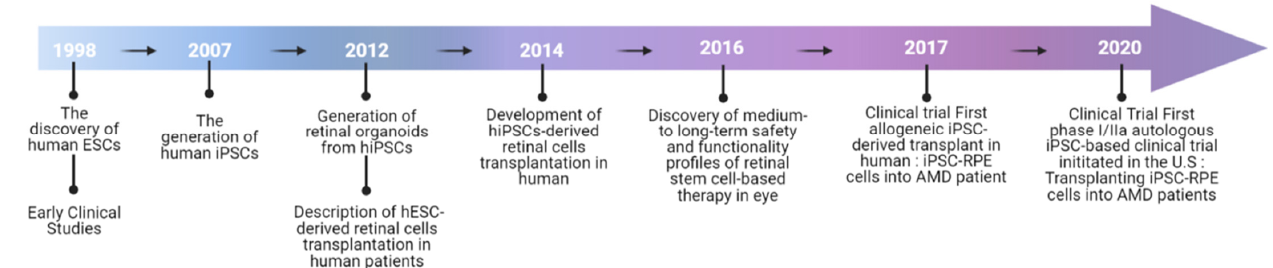
Figure 3. Timeline of the application of PSC-derived retinal cells in clinical studies.